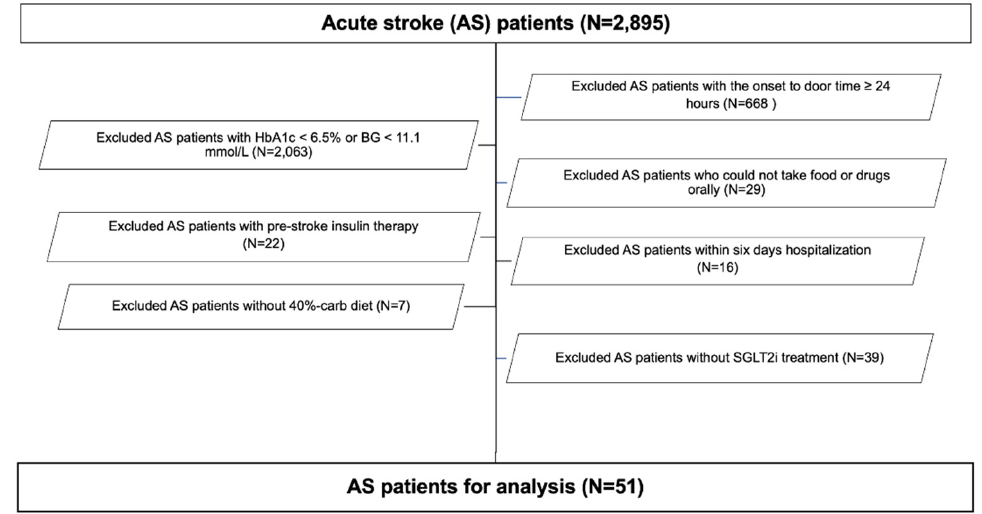
Figure 1. Flow chart of patient selection for the analysis. BG, blood glucose; carb, carbohydrate; HbA1c, glycated hemoglobin; SGLT2i, sodium-glucose cotransporter 2 Table 1. Patient characteristics (N = 51).